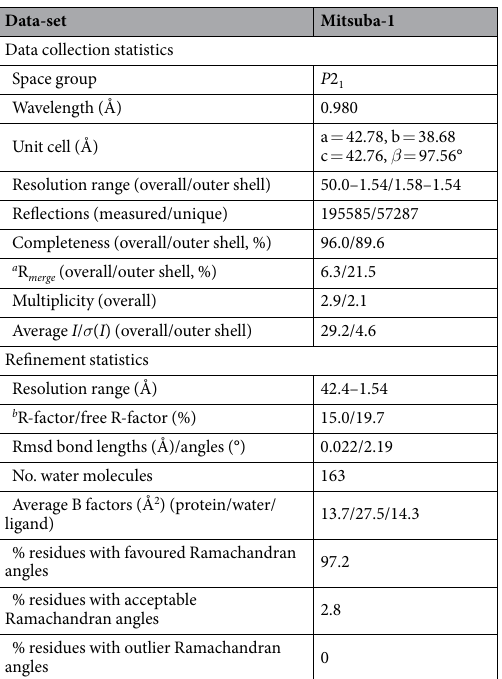
Table 1. a Rmerge = ∑ I i − 〈 I 〉 / ∑ I i , where I i is the intensity of an observation and 〈 I 〉 is the mean value for this reflection, and the summations are over all reflections. Values in parentheses are for the highest resolution shell. b R factor is ∑ − | Fc ( h )||/ ∑ h || Fo ( h )| h Fo ( h ), where Fo and Fc are the observed and calculated structure factor amplitudes, respectively. The free R factor was calculated with 5% of reflections omitted from the